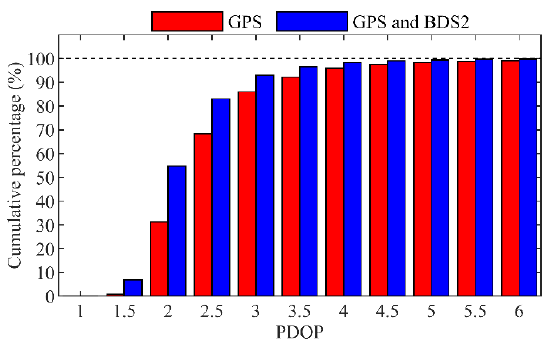
Figure 14. Cumulative percentages of the PDOP values of GPS-only and GPS + BDS2 along the tra ‐ jectories of TH ‐ 2A.